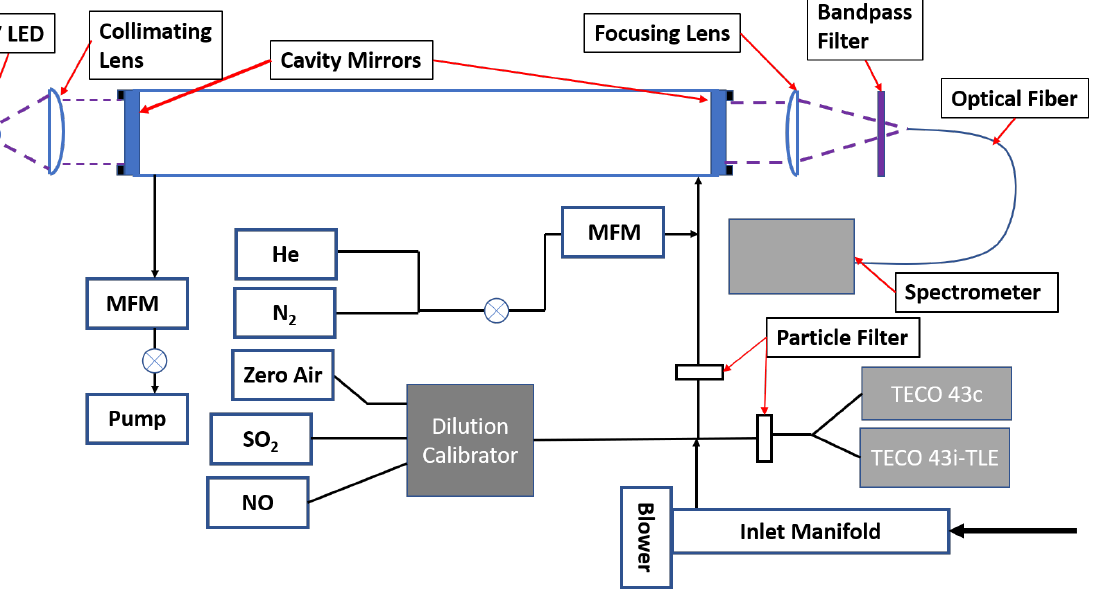
Figure 2. Schematic of BBCEAS cavity as set up for comparison with the SO 2 standard and ambient sampling. Flow is pulled into the system, and the total flow of the sample and the overflow are measured by mass flow meters (MFM). BBCEAS measurements are made in parallel with the Thermo Electron Corporation (TECO) 43 series